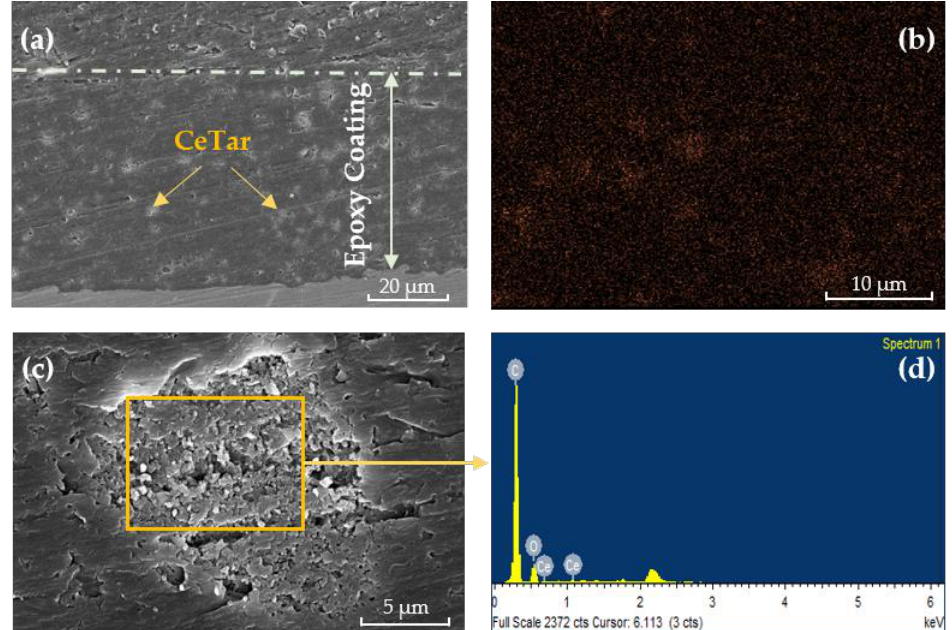
Figure 2. Cross-sectional SEM images and EDS results of the epoxy coating containing CeTar: ( a ) cross-sectional SEM image; ( b ) Ce EDS mapping image; ( c ) enlarged image of white particles; ( d ) EDS result of white